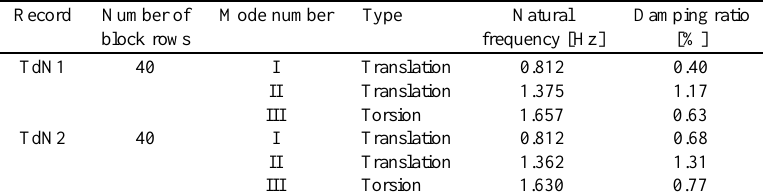
Table 3 Output-only modal identification results (Covariance-Driven